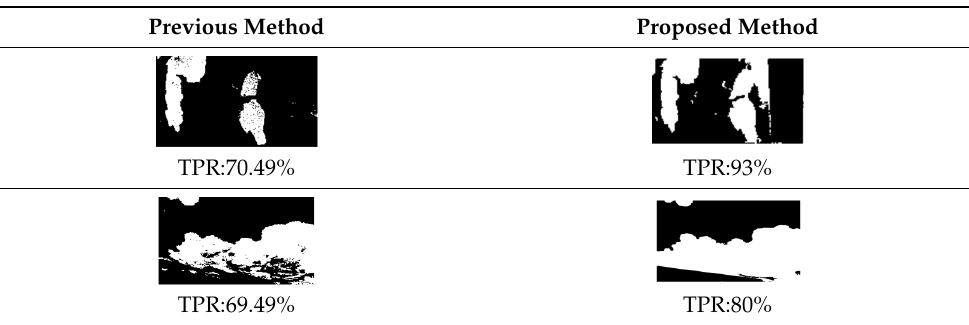
Table 8. Comparative results with previous method.